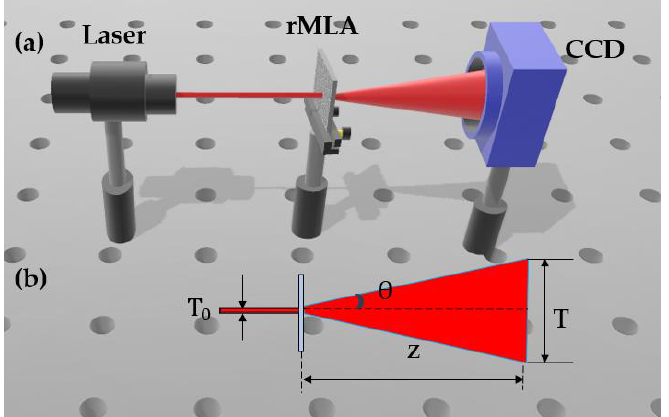
Figure 10. Experimental measurement: ( a ) the experimental setup; and ( b ) the diagram of geometric calculation method.